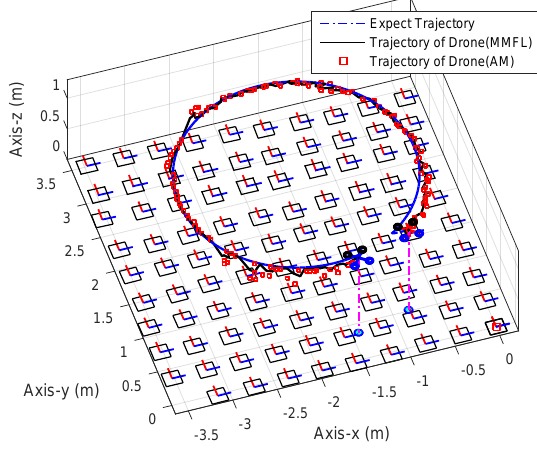
Figure 14. Trajectory of Autonomous